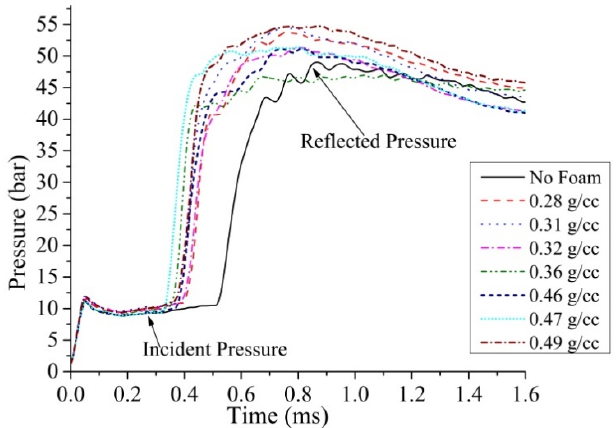
Figure 3. Variation of incident and reflected shock pressures with time (sensor-1). Table 1. Effect of foam density on foam plastic deformation and shock pressures.